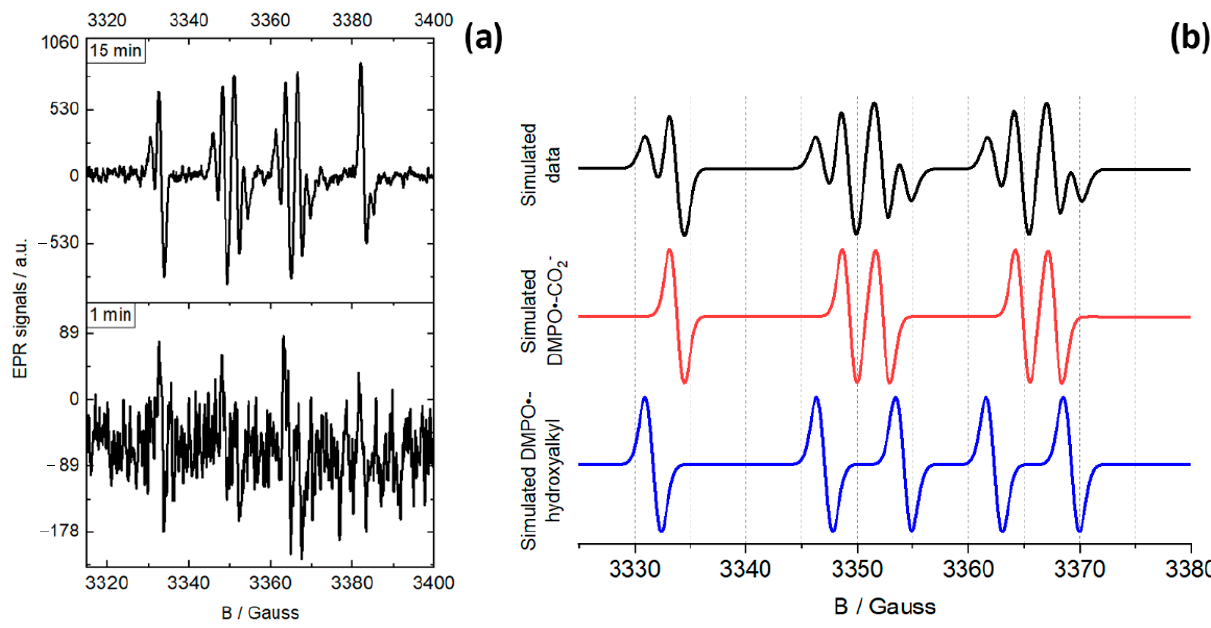
Figure 3. EPR spin trap spectra in N 2 atmosphere during UV irradiation; ( a ) experimental spectra; and ( b ) simulated spectra. The suspension consisted of oxalic acid (5.5 mmol L − 1 ), DMPO (0.8 mmol L − 1 ), and Pt/TiO 2 (1 g L − 1 ). The extracted spectra in Figure 3b were normalized to demonstrate the overlap between the diverse species.